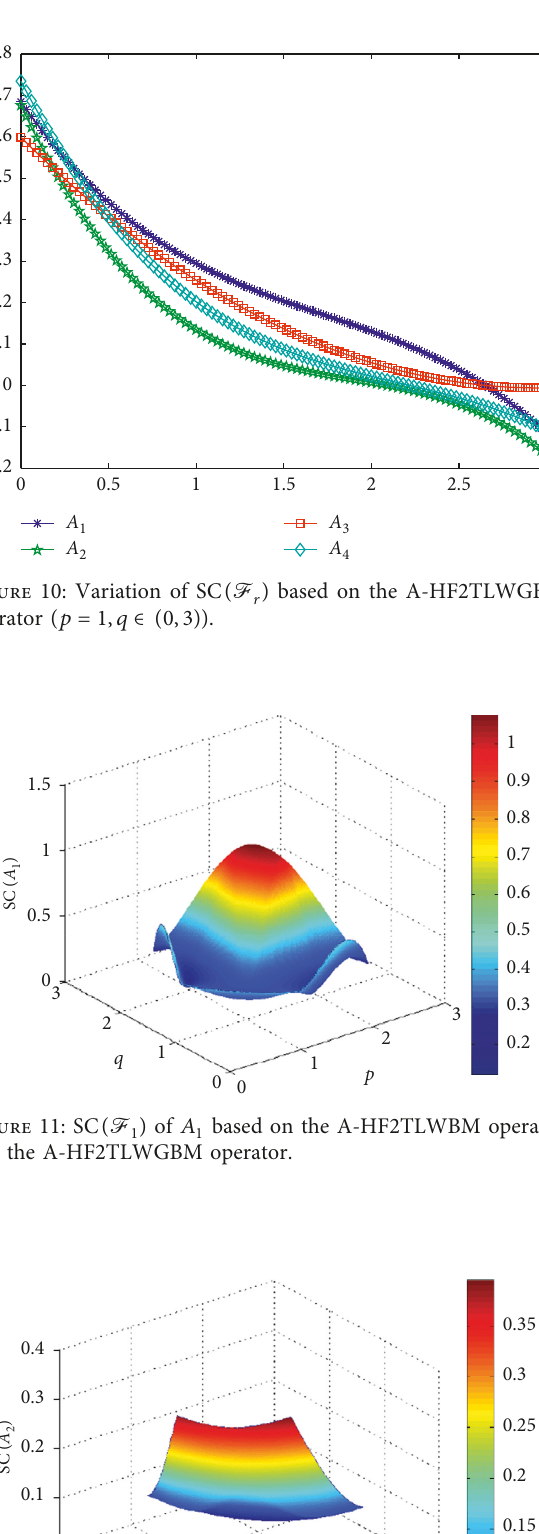
) of A based on the A-HF2TLWBM operator 2 2